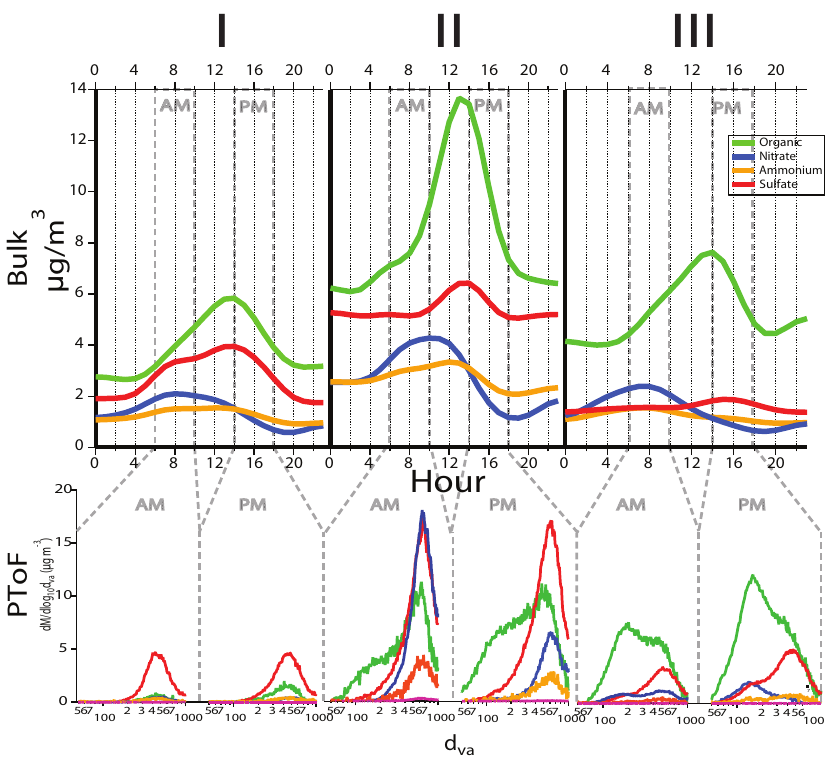
Fig. 3. Bulk AMS diurnal mass averages for regimes I, II, and III. Bottom panel shows size-resolved PToF AMS data for a representative morning and afternoon period in each regime, where morning=07:00–11:00LT and afternoon=15:00–19:00LT.